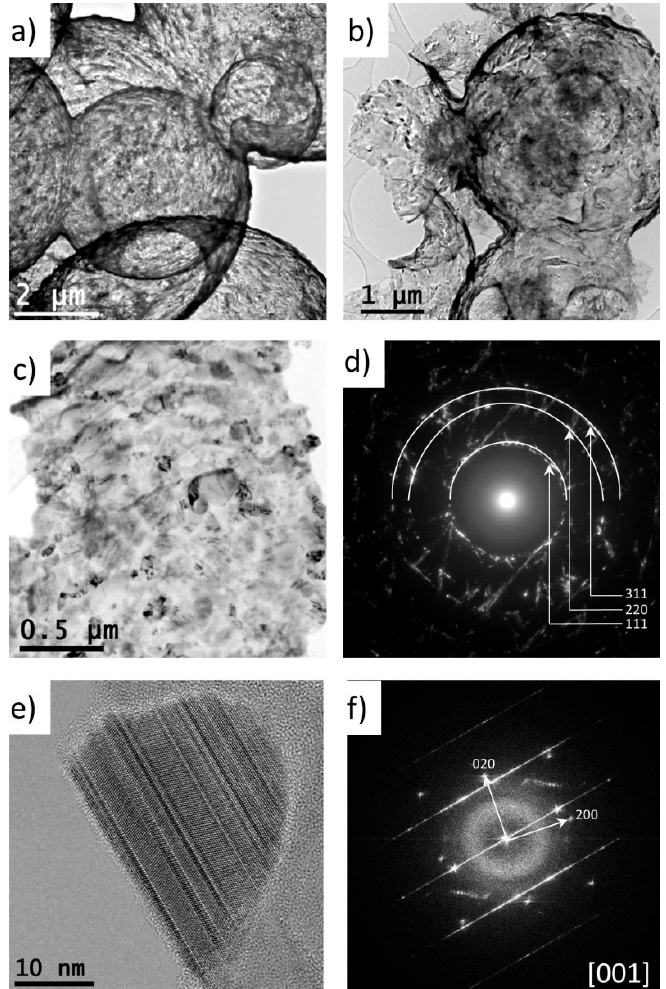
Figure 4. TEM images of hollow spheres of SiC: ( a ) and ( b ) Bright-field TEM image showing an overview of the hollow spheres’ morphology; ( c ) TEM image of polycrystalline grains from which the hollow shell is formed; ( d ) the corresponding selected-area electron diffraction (SAED) pattern; ( e ) HRTEM image of a single grain showing a high density of stacking faults; ( f ) the corresponding fast Fourier transform.